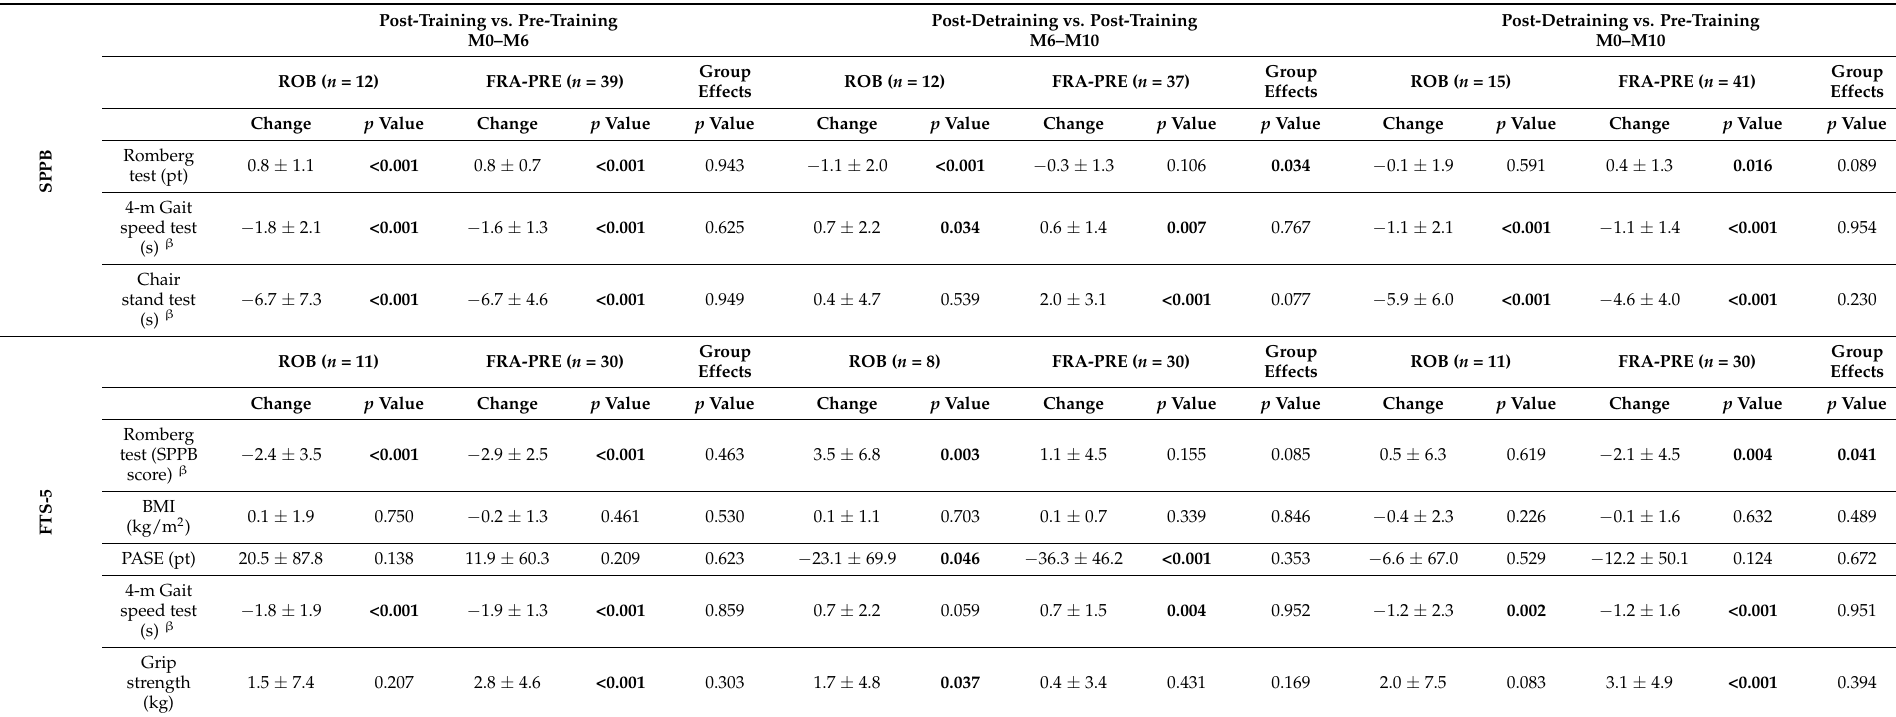
Table 6. Changes in specific tests of SPPB and FTS-5 at different time points in the training